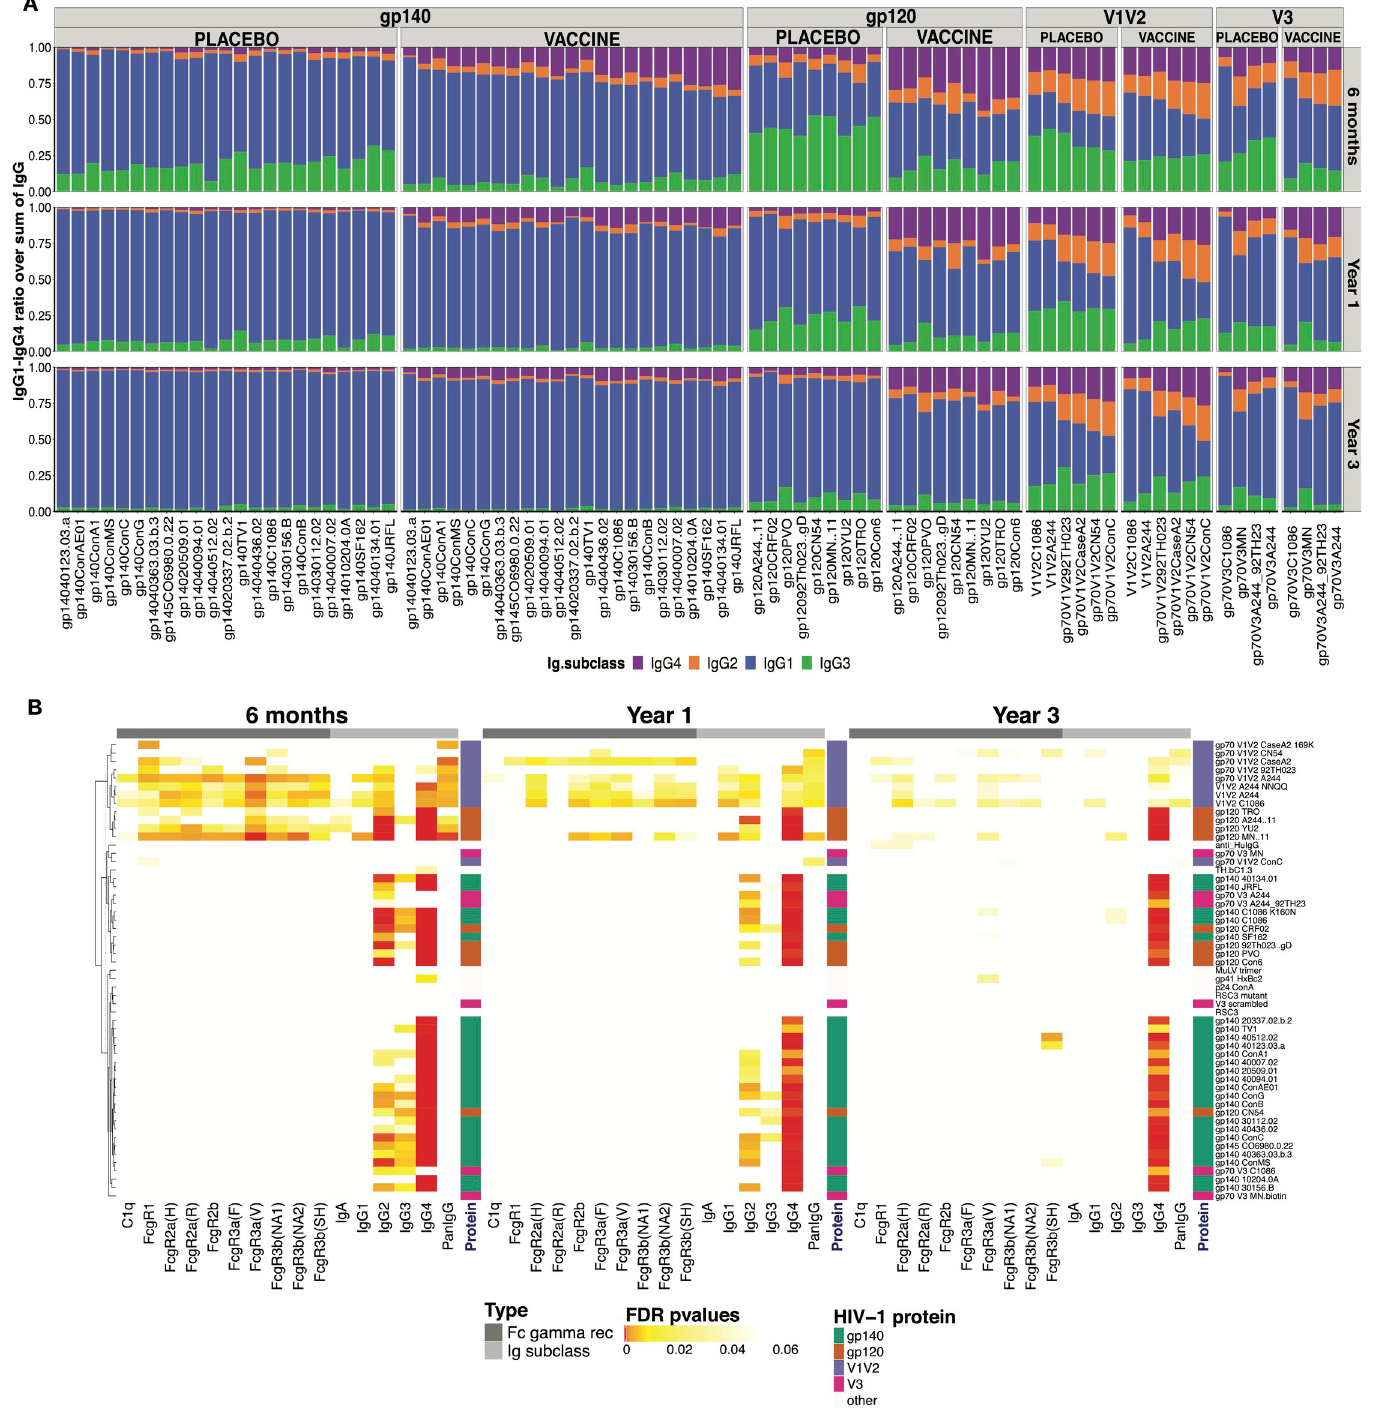
Fig 1. RV144 vaccination primed IgG2, IgG4 and V1V2 binding responses after HIV-1 breakthrough infection. ( A) Distribution of IgG subclasses to HIV-1 antigens in vaccine and placebo recipients at 6 months (N = 24 vaccine, 31 placebo), one year (N = 18 vaccine, 39 placebo), and three years (N = 27 vaccine, 49 placebo) after HIV-1 diagnosis. Mean signal of antigen specific IgG1, IgG2, IgG3 and IgG4 (blue, orange, green, purple, respectively) are represented as a fraction of the sum of all IgG subclasses. (B) Significant differences between vaccine and placebo groups, using Mann–Whitney U test, measured at 6 months, 1 and 3 years after diagnosis are represented with colored cells. Each cell represents FDR-adjusted p-values where the color indicates the statistical significance: FDR � 0.001 in red, FDR � 0.01 in orange, FDR � 0.05 in yellow and white marks non-significant differences. Columns represent binding responses against complement (C1q), Fc γ Rs, Ig isotypes and subclasses. Each row corresponds to an HIV-1 antigen: gp140 (green), gp120 (orange), V1V2 (purple) and V3 (magenta). The axis on the right represents the hierarchy of clusters. https://doi.org/10.1371/journal.ppat.1009101.g001 PLOS Pathogens| https://doi.org/10.1371/journal.ppat.1009101 December 8,